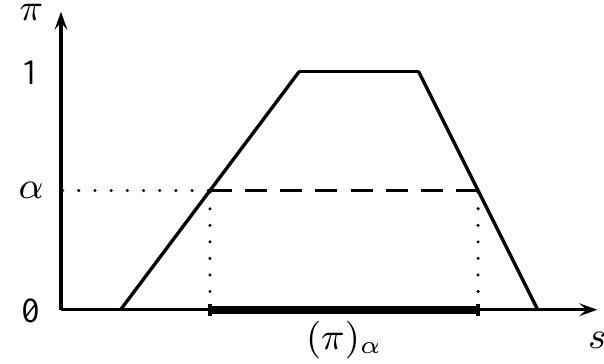
Fig. 1. Trapezoidal possibility distribution with indication of an α -cut ( π ) α .